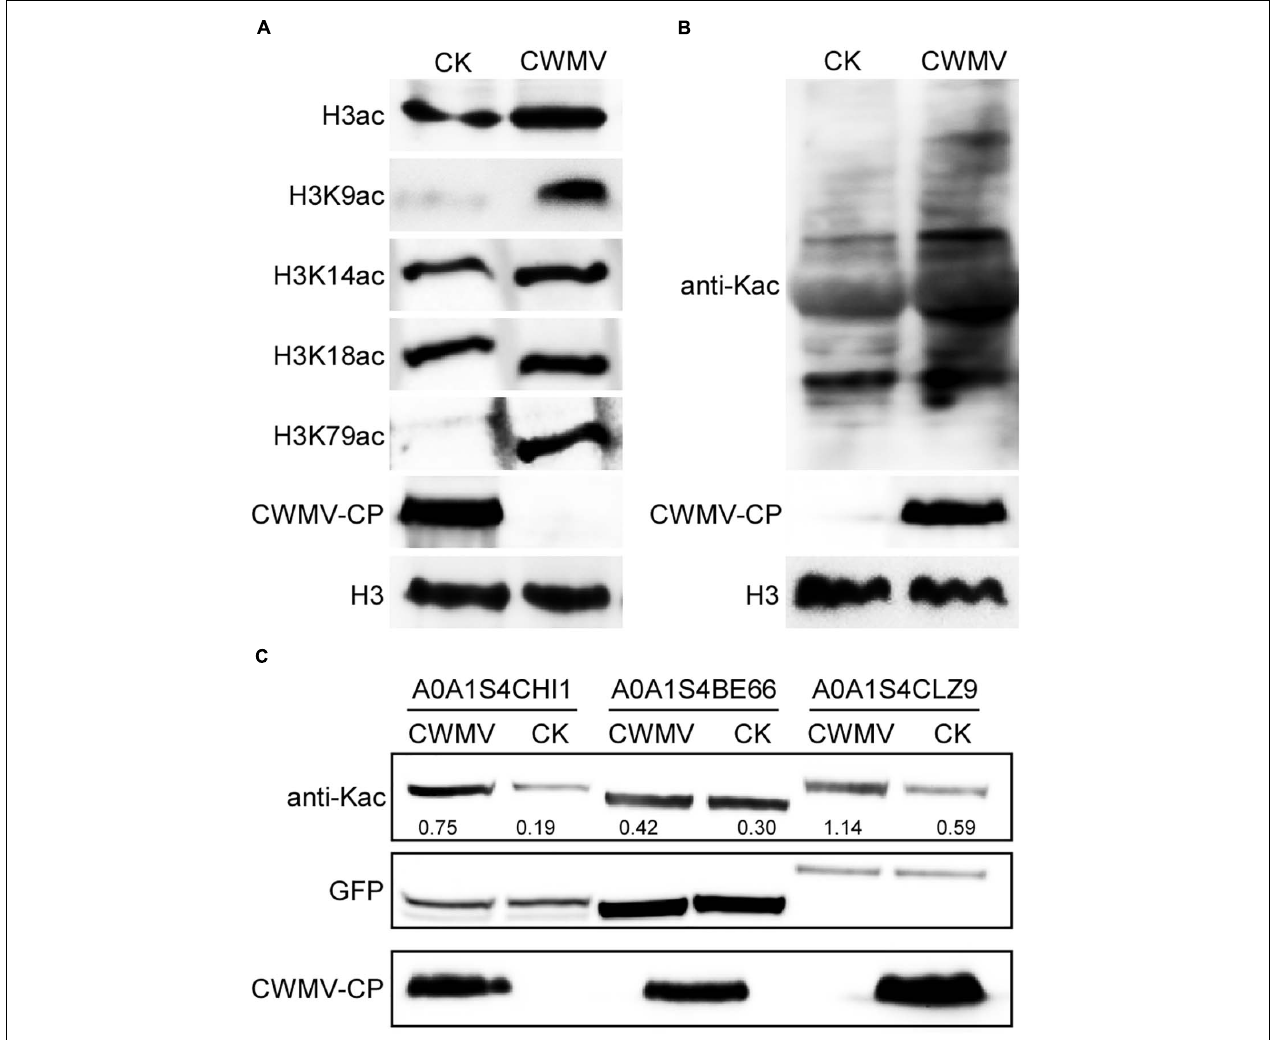
FIGURE 8 | Protein acetylation levels in CWMV-infected and uninfected N. benthamiana . (A) Western blot analyses of different acetylated lysine sites on histone H3 in CWMV-infected and uninfected N. benthamiana leaf samples using H3K9ac-, H3K14ac-, H3K18ac-, and H3K79ac-specific antibodies. The expression level of CWMV-CP in the same samples was used to confirm the infection. The expression level of histone H3 in the same samples was used as an internal control. (B) Western blot analyses of chloroplast proteins extracted from CWMV-infected and the uninfected N. benthamiana leaves using anti-Kac antibodies. The expression level of CWMV-CP in the same samples was used to confirm the infection. The expression level of histone H3 in the same samples was used as an internal control. (C) Western blot analyses of selected proteins extracted from CWMV-infected and the uninfected N. benthamiana leaves using anti-Kac antibodies and anti-GFP antibodies. The expression level of CWMV-CP in the same samples was used to confirm the infection. The expression level of protein fused with GFP in the samples was used as an internal